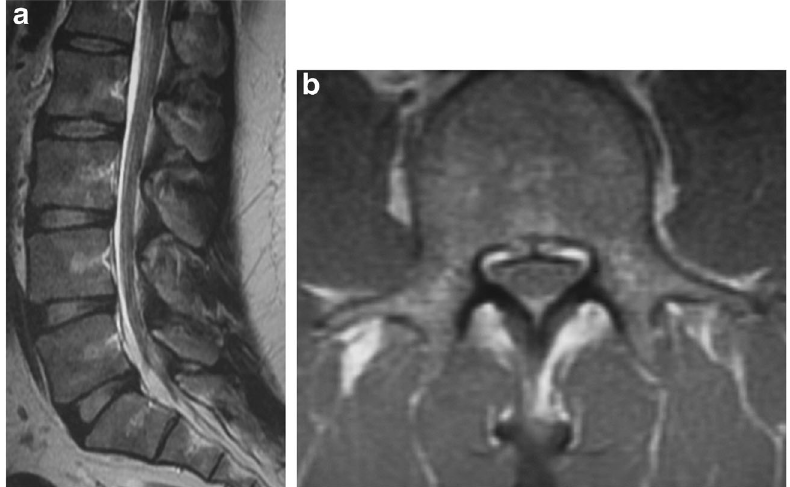
Fig.17 Congenital stenosis ofthe spinal canal: Sagittal ( a ) and axial ( b ) T1-weighted MR images of the lumbar spine reveal narrowed anteroposterior diameter of the spinal canal (< 10